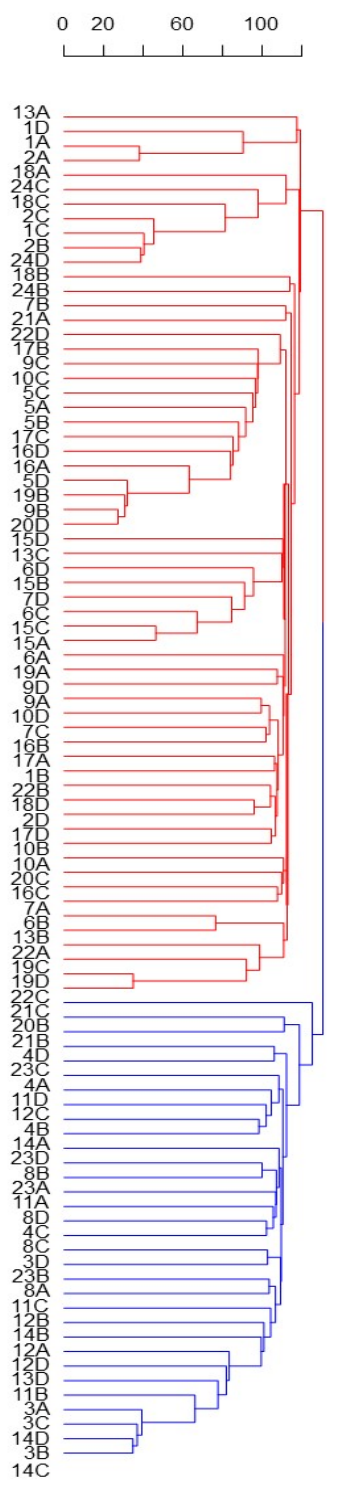
Figure 3. HCA based on Euclidean distances and average-linkage agglomeration method computed by using single Seed dataset (15,959 SNP markers and 93 genotypes). Labels indicate the number ID of the 24 Solina accessions, and letters correspond to the four different seeds (A, B, C, D) analyzed. Two Solina clusters were highlighted by different colors.